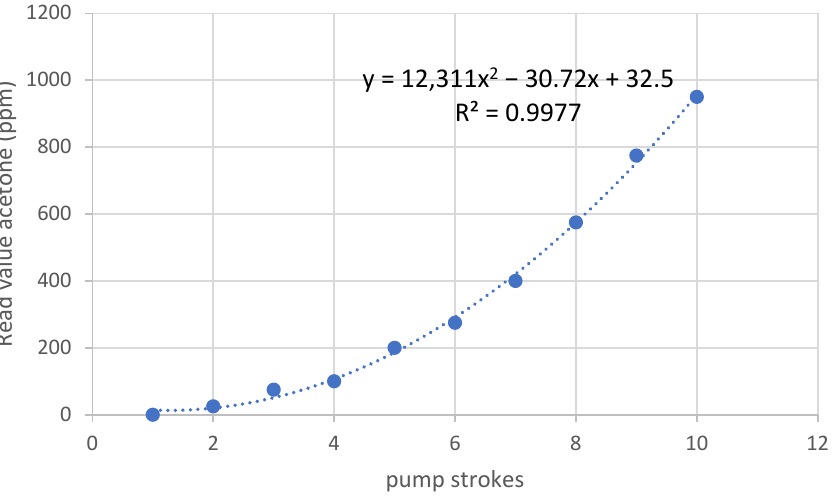
Figure 4. Example of the calculation of ppm values for acetone in breath from read values. The expected read value at pump stroke 2 in this example is 12.311 × (2) 2 − 30.72 × (2) + 32.5 = 20.304; calculated acetone concentration for this sample is 20.304 × 0.4 (2 − 1) = 8.12 ppm.